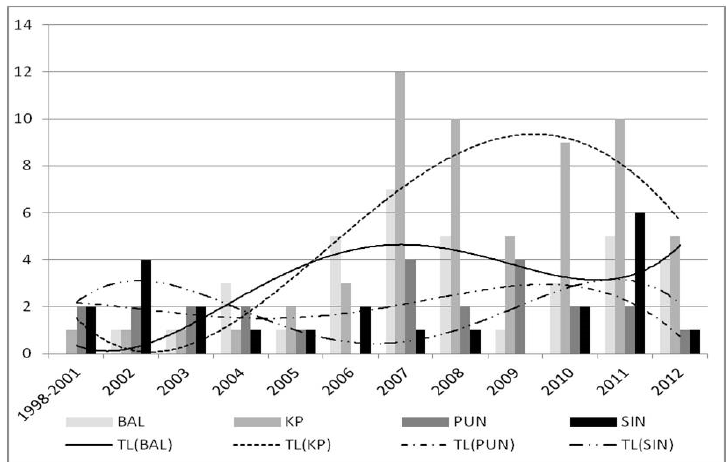
Figure 4. Number of Event–Target clusters obtained annually for each province.